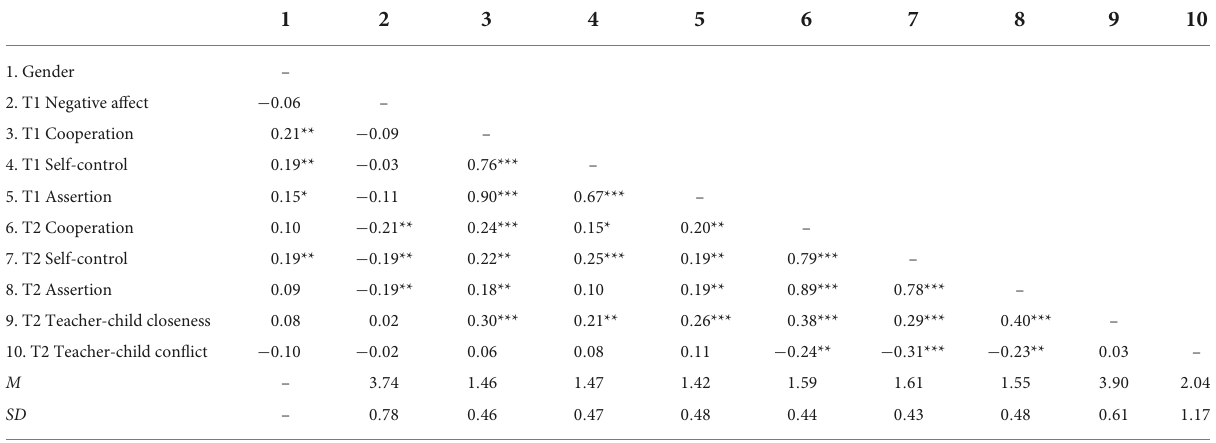
TABLE 1 Correlations among study